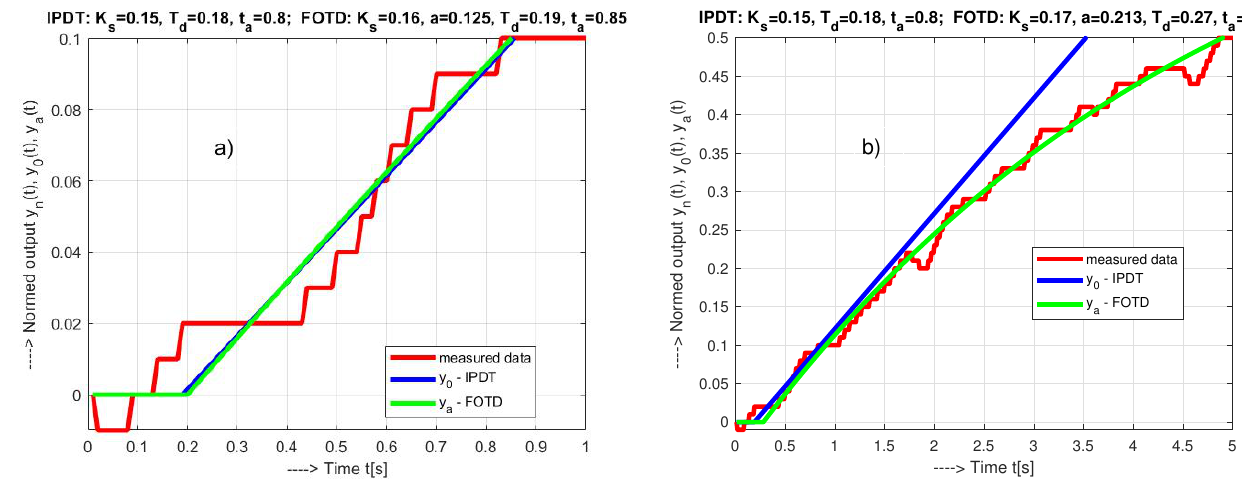
Figure 5. Approximations of an initial part of a normed step response y ( t ) for t a ≤ 1 ( a ) and t a ≤ 5 ( b ) with model parameters corresponding to the maximal values T d from particular “optimal” solutions fulfilling conditions